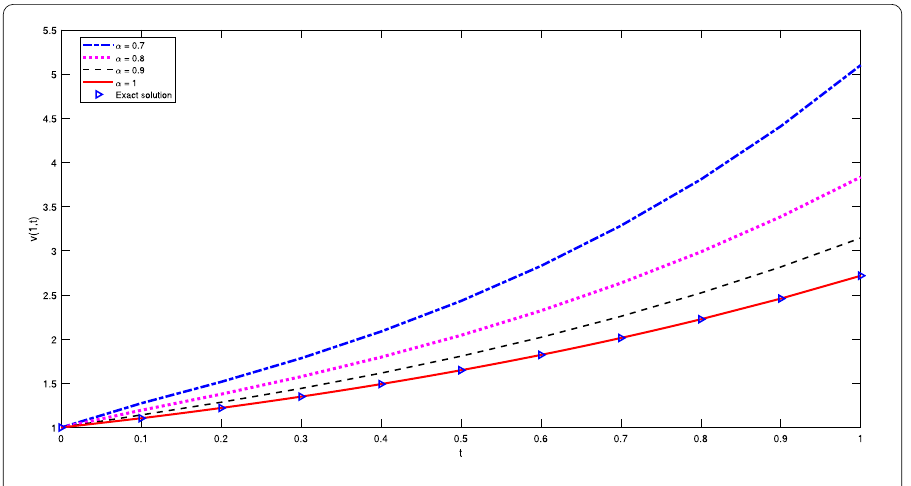
Figure 3 Evolution of LTVIM’s fourth iteration approximate solution of Example 4.2 for x = 1, t ∈ [0,1] and different values of α